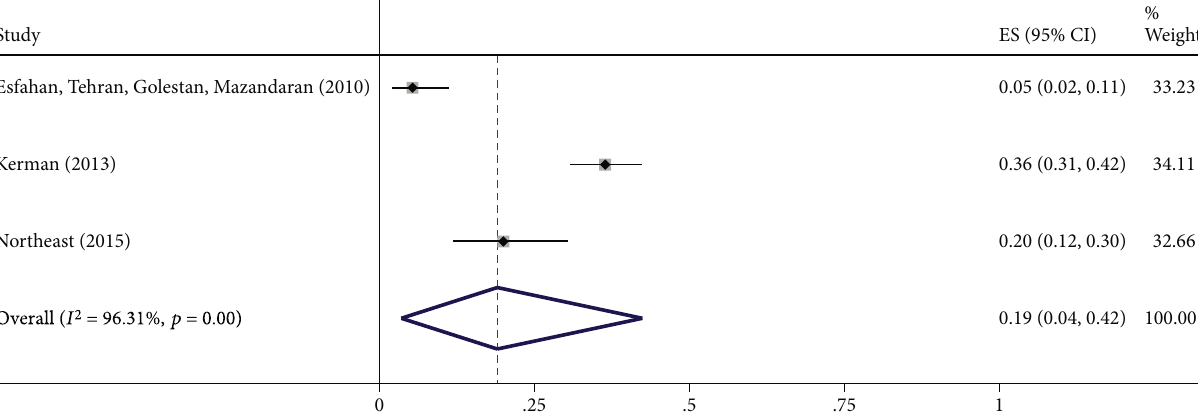
genotype prevalence in 7